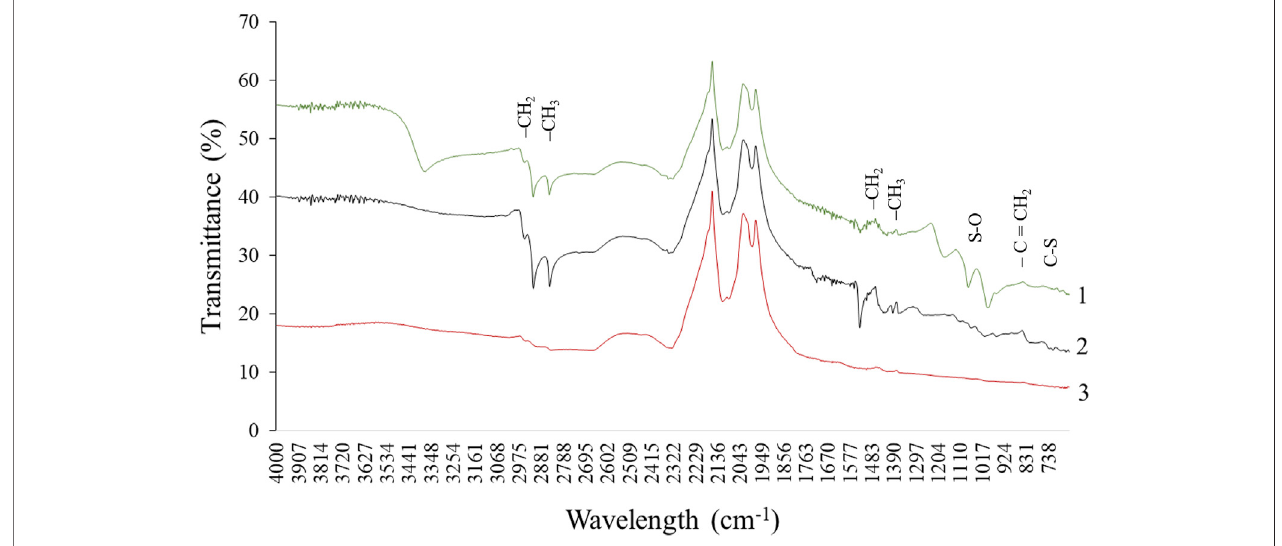
FIGURE 2 | FTIR spectra of rubber particles after biological treatment (A) , after chemical treatment (C) , and without treatment as a negative control (B) .